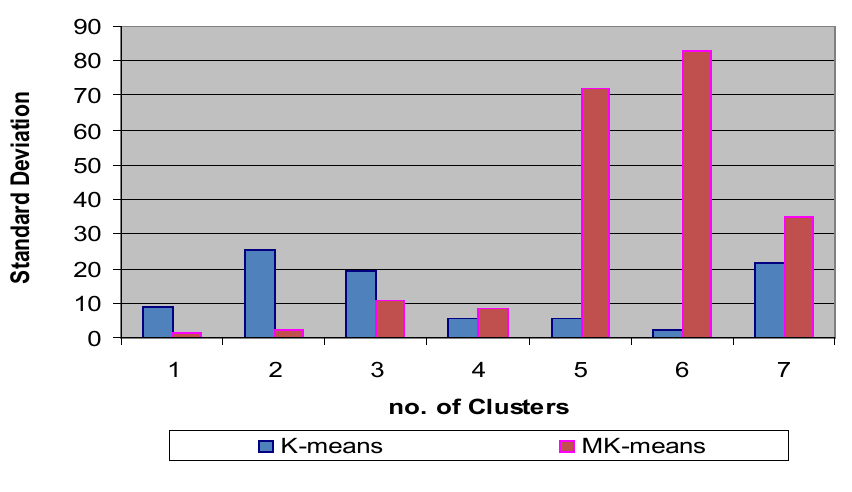
Figure 8. Difference between K-means and MK-means in 7 clusters